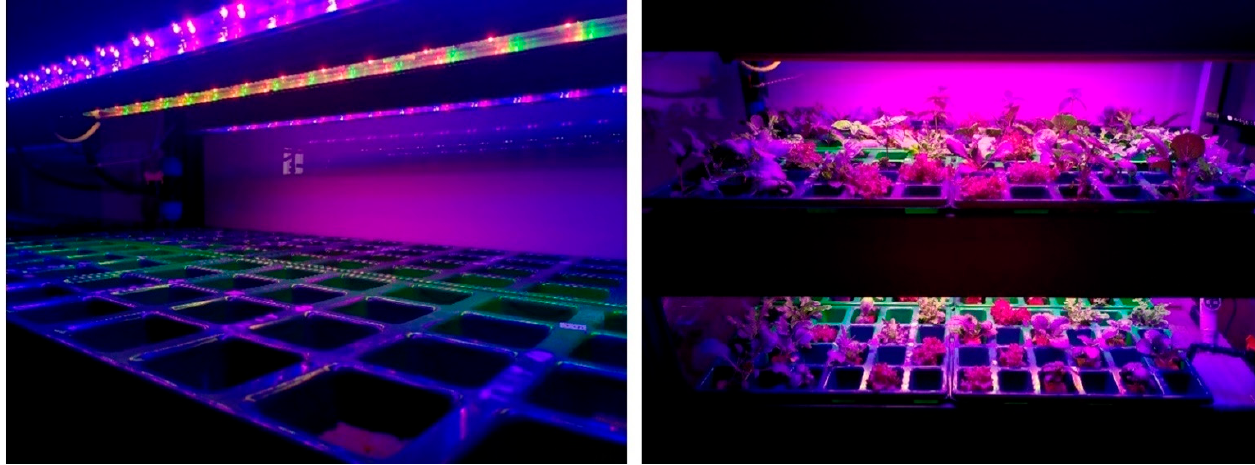
Figure 2. LED units and planting trays ( left ) and an overview of PL about two weeks after germi- nation ( right ) (Photos: Cichocki, 2020).